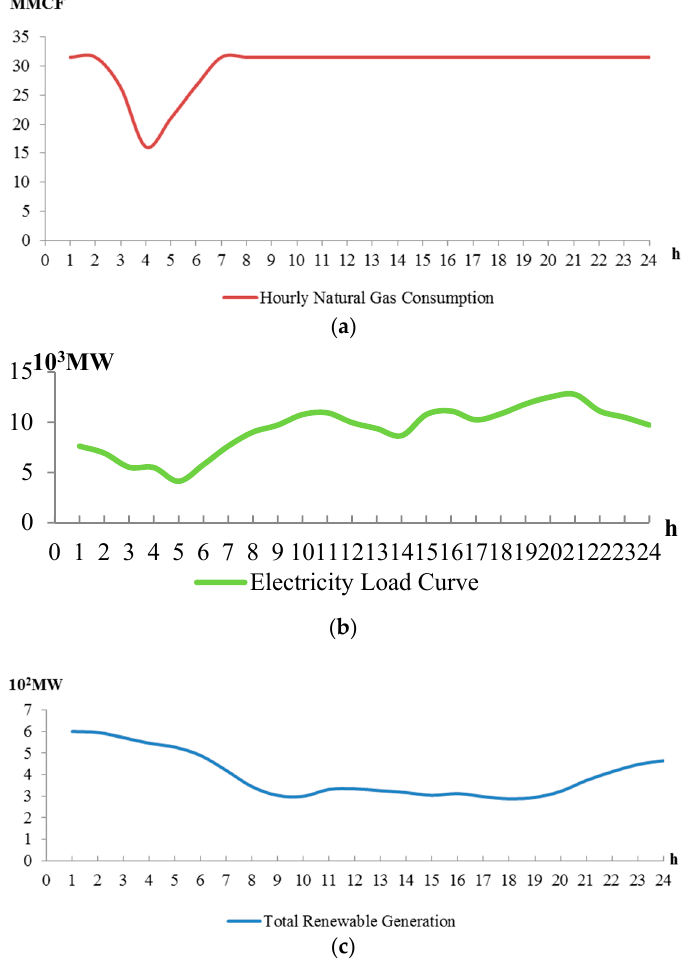
Figure 5. Load and generation curves: ( a ) Natural gas load curve; ( b ) Electricity load curve; ( c ) VRES generation curve.